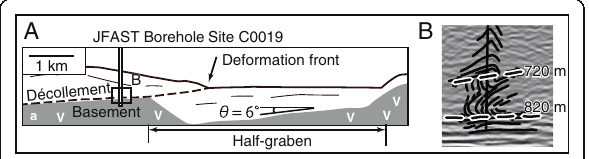
Fig. 1 a Interpretation of a seismic reflection profile before the 2011 earthquake (Kodaira et al. 2012). b Apparent dip of bedding in the in-line seismic section derived from borehole LWD resistivity images across the plate boundary through the fault zone (Chester et al.